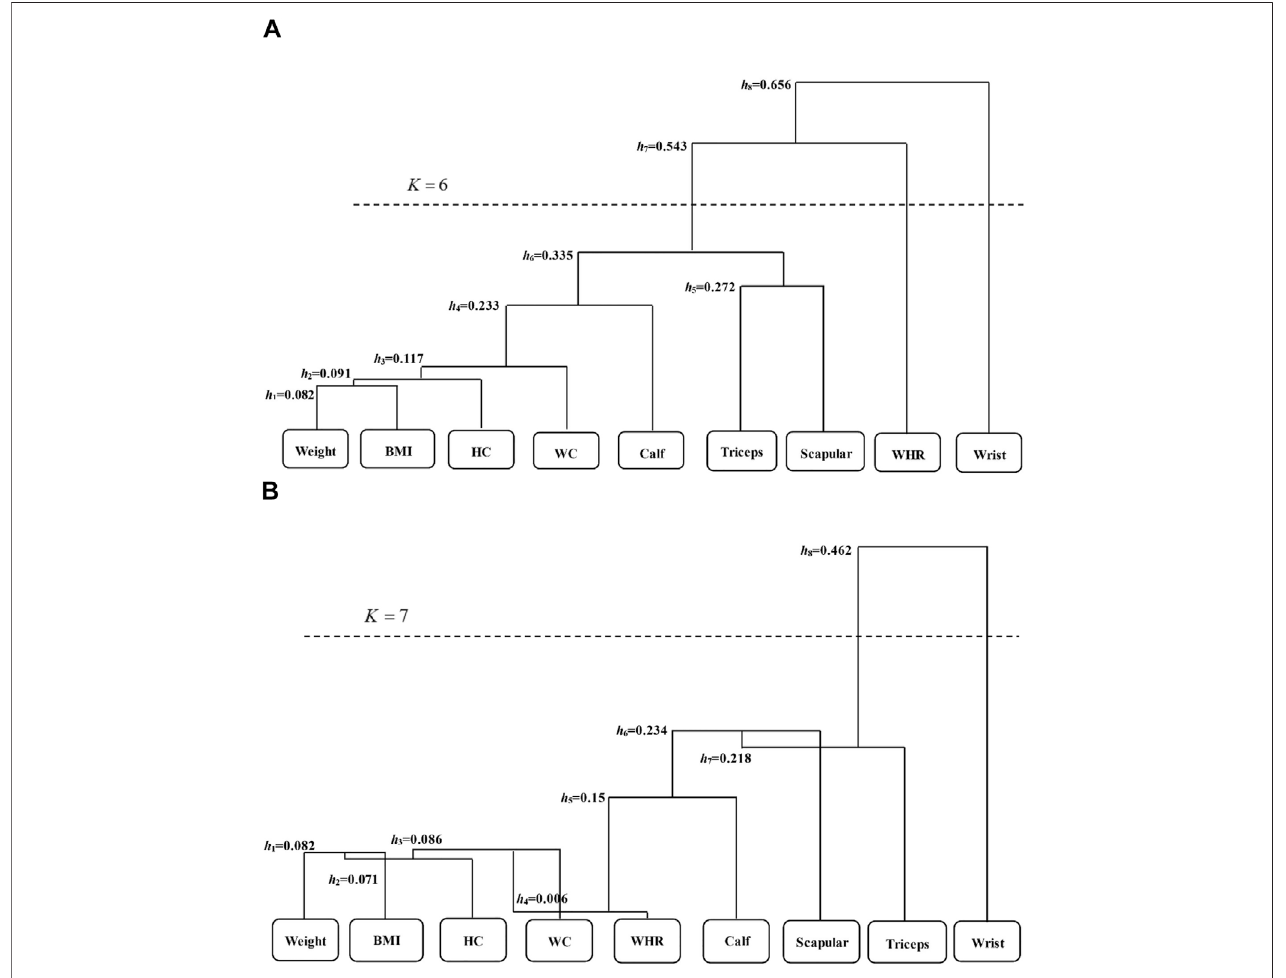
FIGURE 2 | The dendrogram of the nine phenotypes in the ARIC study via HCM (A) and HCDC (B) . h represents the maximum value of correlation coef fi cient in each clustering process, which is taken as the “ branch length ” of the clustering tree. K reveals the fi nal clustering times according to the stopping criteria. BMI is body mass index; Triceps is average skinfold thickness of triceps brachii; Scapular is mean subscapular skinfold thickness; WC is waist; HC is hip girth; WHR is waist-to-hip ratio; Calf is calf girth; and Wrist is wrist breadth.